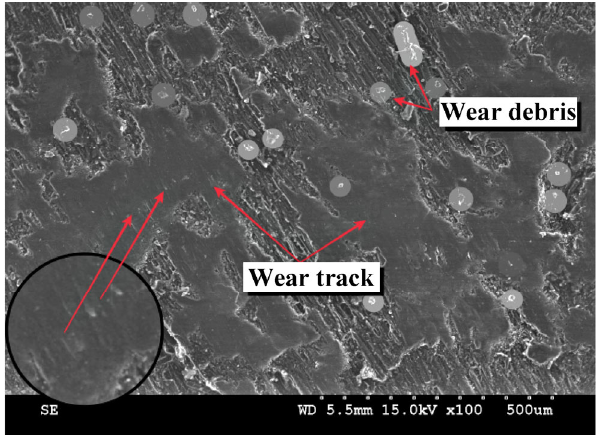
Fig. 12 SEM micrograph of sample CpC25 representing the smooth surface caused by sliding, and wear voids caused by removal of matrix flakes